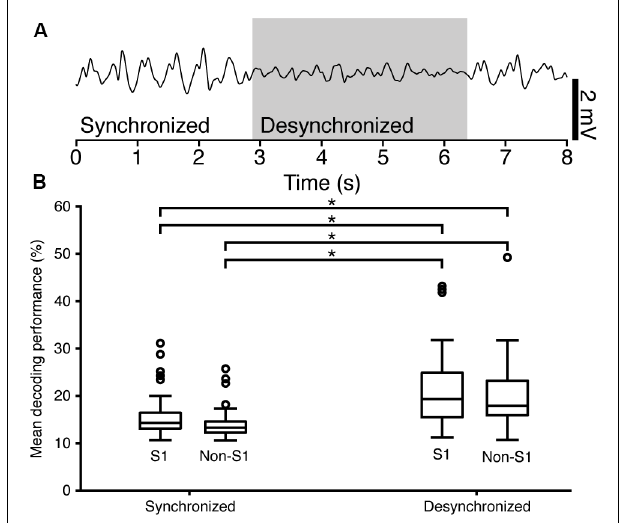
FIGURE 5 | Electroencephalogram (EEG) state segmentation and decoding performance. (A) An example of a raw EEG recording, smoothed by a 100 ms moving Hanning window. The segment of the recording that was classified as being desynchronized is indicated by a box in light gray. (B) Box-plot of the mean decoding performance for S1 neurons grouped by EEG state (Synchronized N = 43; Desynchronized N = 26) and for non-S1 neurons, also grouped by EEG state (Synchronized N = 24; Desynchronized N = 20). Connecting lines with star between sub-groups indicate statistically significant differences as specified in Table 2 .